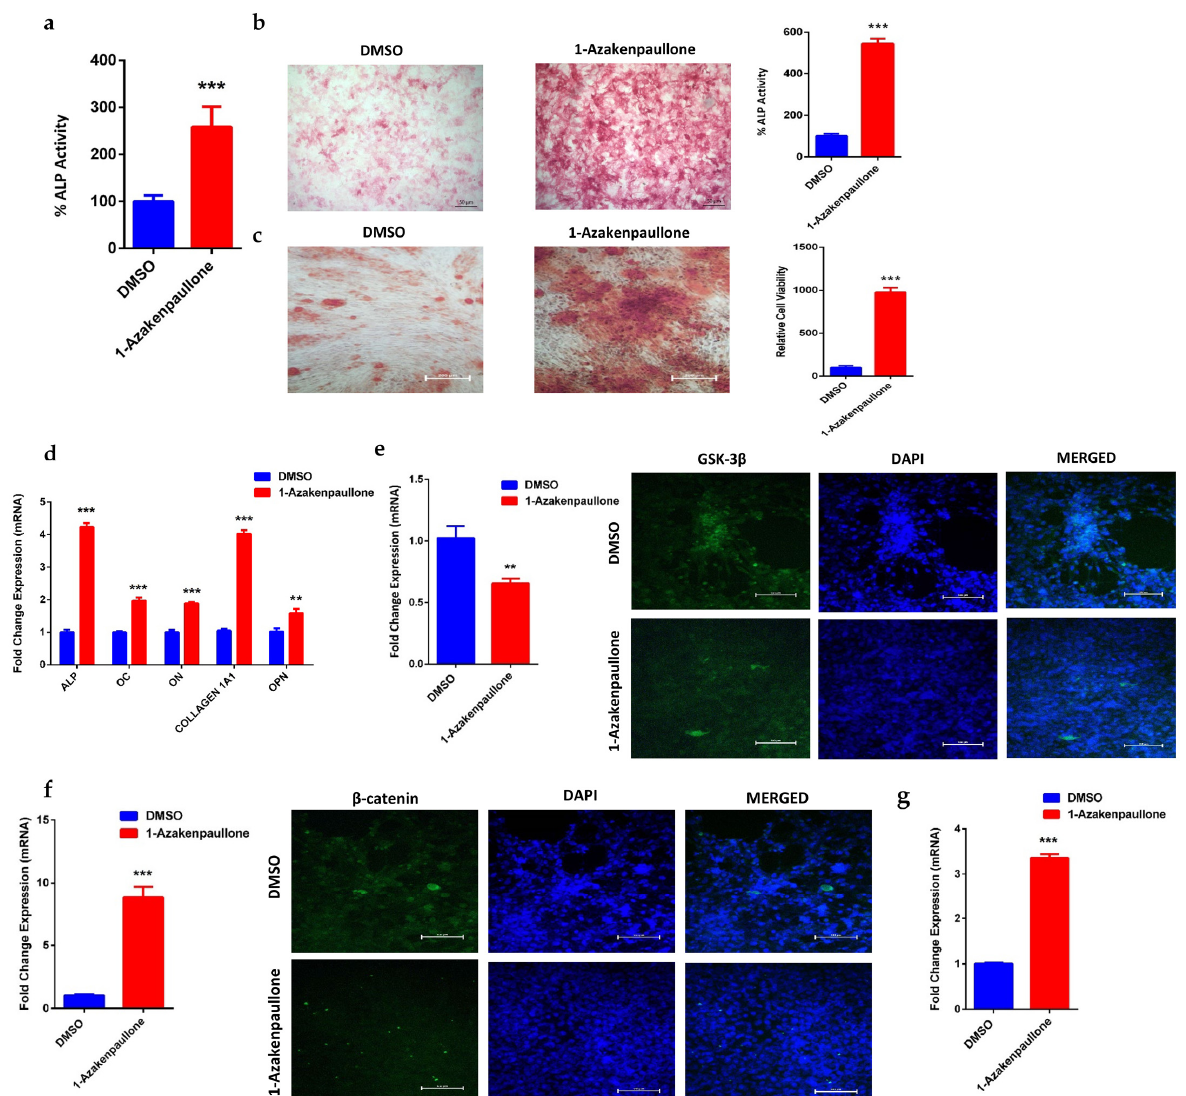
Figure 2. Effects of 1-Azakenpaullone treatment on the on the osteoblastic differentiation, mineraliza- tion, and gene expression of human MSCs. ( a ) Quantification of ALP activity in 1-Azakenpaullone- treated human MSCs (3.0 µ M) versus DMSO-treated control cells on day 10 post osteoblastic differ- entiation. Data are presented as mean percentage ALP activity ± SEM ( n = 15). ( b ) Representative alkaline phosphatase (ALP) staining of 1-Azakenpaullone-treated human MSCs (3.0 µ M) versus DMSO-treated control cells on day 10 post osteoblastic differentiation; percentage of ALP staining was quantified. Photomicrographs magnification × 5. ( c ) Cytochemical staining for mineralized matrix formation using Alizarin red stained on day 14 post osteoblastic differentiation in the ab- sence (left panel) or presence (right panel) of 1-Azakenpaullone (3.0 µ M); percentage of Alizarin red staining was quantified. Photomicrograph magnification × 10. ( d ) Quantitative RT-PCR analysis for gene expression of ALP, OC, ON, COL1A1, and OPN in human MSCs on day 10 post osteoblast differentiation in the absence (blue) or presence (red) of 1-Azakenpaullone (3.0 µ M). ( e ) Expression of GSK-3 β in human MSCs treated with 1-Azakenpaullone (3.0 µ M) for 48 h in quantitative RT-PCR analysis the absence (blue) or presence (red) of 1-Azakenpaullone (3.0 µ M) for gene expression and immunocytochemistry for protein expression, scale bar: 100 µ M. ( f ) Expression of β -catenin in human MSCs treated with 1-Azakenpaullone (3.0 µ M) on day 10 post osteoblast differentiation in quantita- tive RT-PCR analysis for gene expression the absence (blue) or presence (red) of 1-Azakenpaullone (3.0 µ M) and immunocytochemistry for protein expression, scale bar: 100 µ M. ( g ) Quantitative